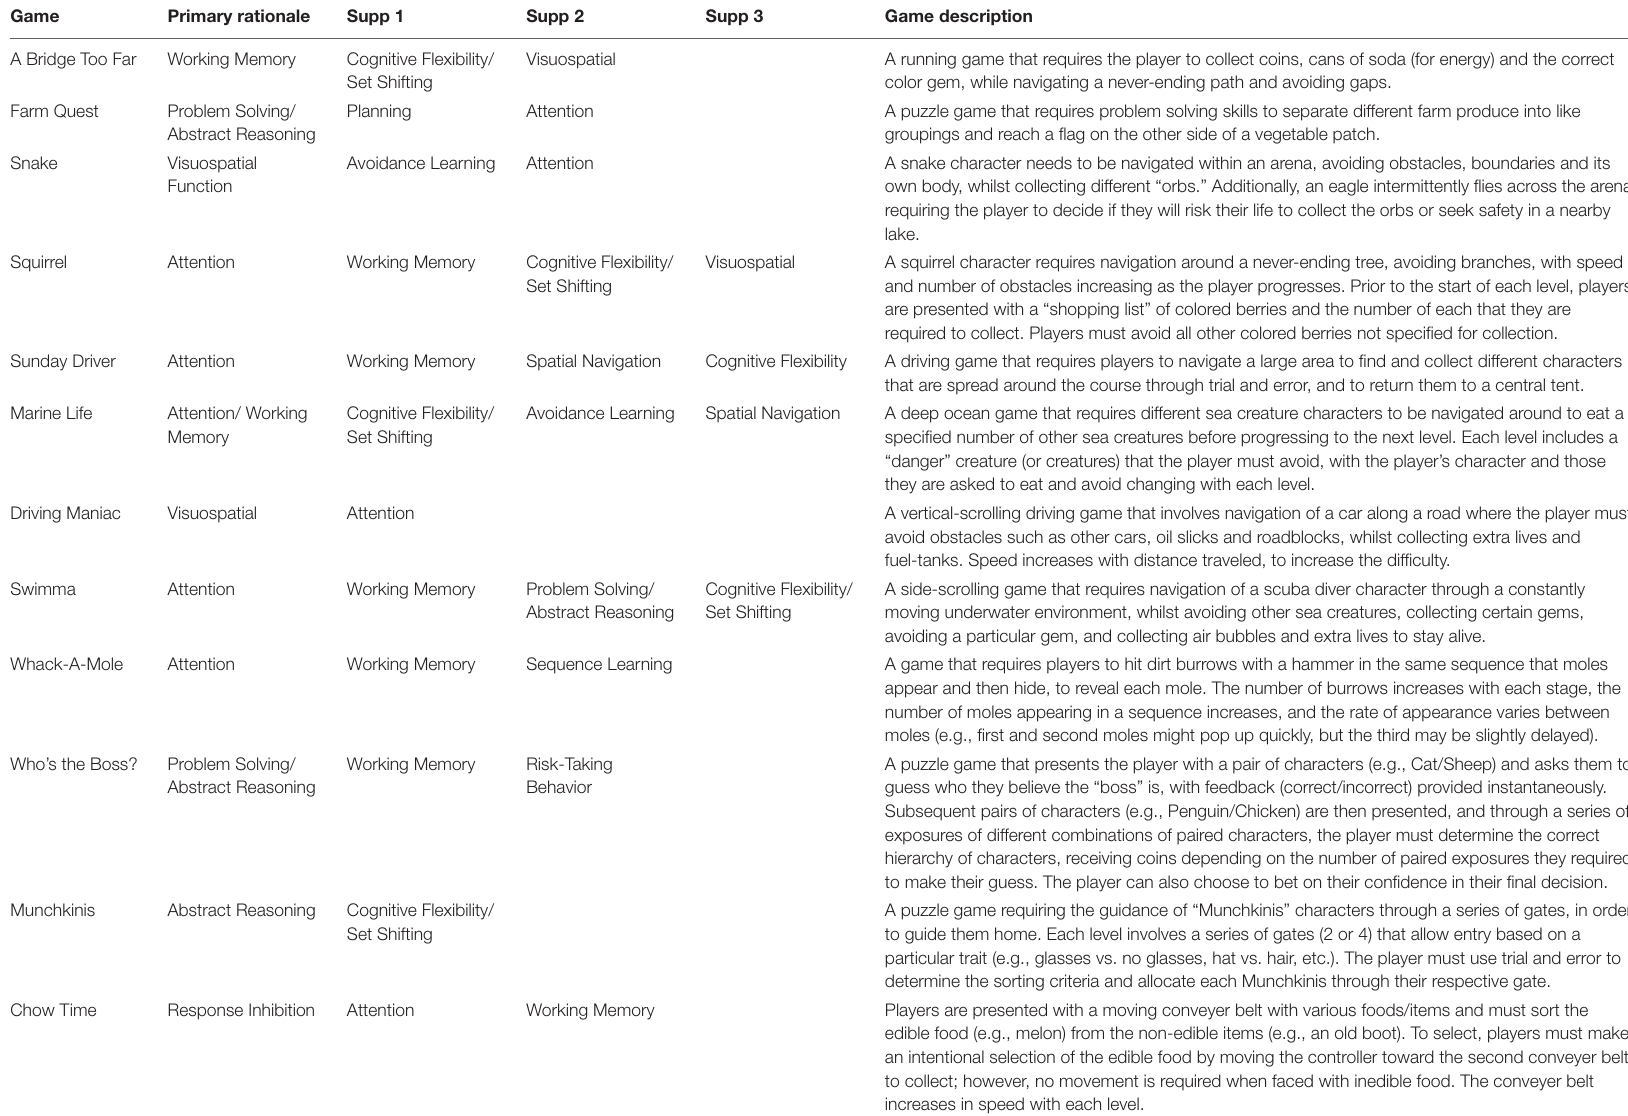
TABLE 1 | Overview of primary and supplementary cognitive domains trained in the gaming suite and game